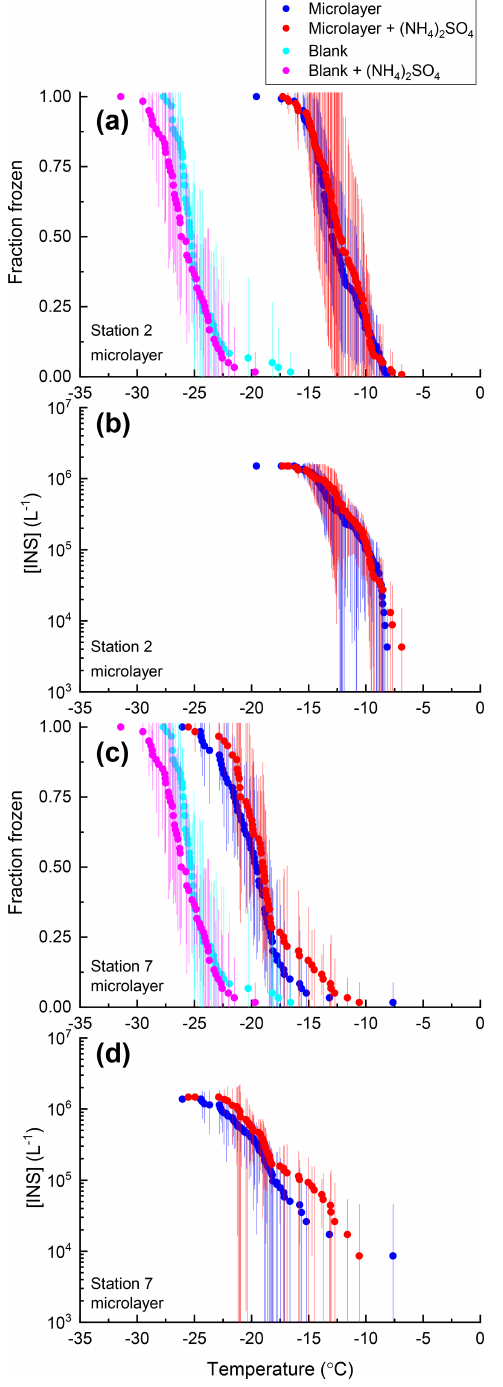
Figure 7. Fraction of droplets frozen (a, c) and ice nucleation ac- tive site densities n m (T ) (b, d) for samples of humic acid (a, b) and fulvic acid (c, d) with (red) and without (blue) 0.05M(NH 4 ) 2 SO 4 compared with an ultrapure water blank with (pink) and with- out (cyan) 0.05M(NH 4 ) 2 SO 4 . Freezing data (both samples and blanks) have been corrected for freezing point depression by 0.05M(NH 4 ) 2 SO 4 . Error bars represent the 95% confidence inter- val of fraction frozen or n m (T ) at temperature T calculated using Student’s t